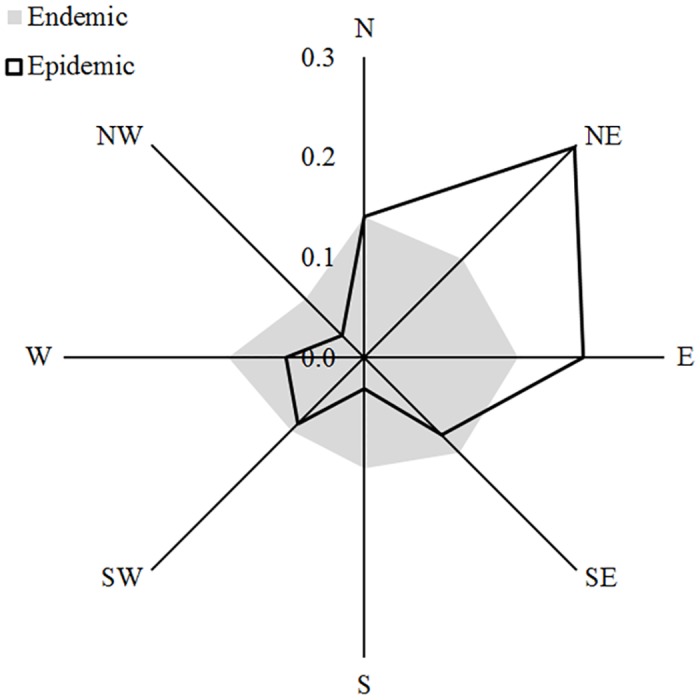
Proportion of stands with endemic and epidemic populations of S. noctilio for each aspect class.